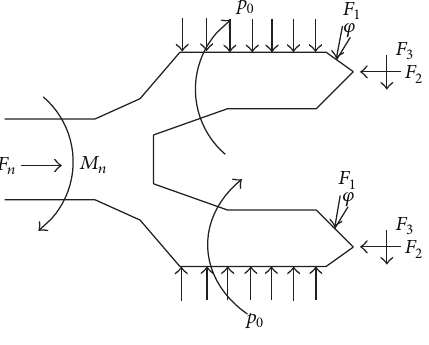
Figure 1: External forces of bit.